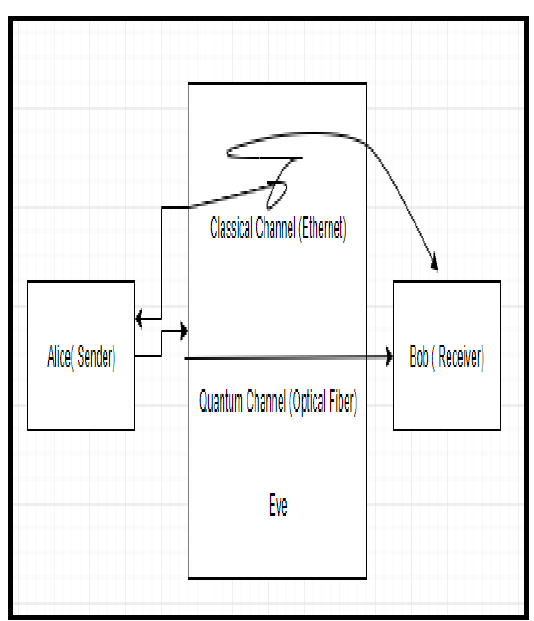
Figure 2. Working Mechanism of